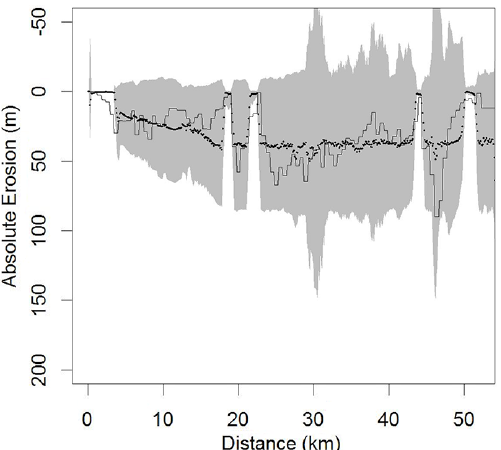
Figure 4. Range of simulated coastline retreat over a 15-year pe- riod, as captured during the ensemble calibration process (grey shadowing). The observed rates of change between 1995 and 2010 (modified from Montreuil and Bullard, 2012) are given as the solid black line and the ensemble member with the lowest RMSE plotted as a series of points for